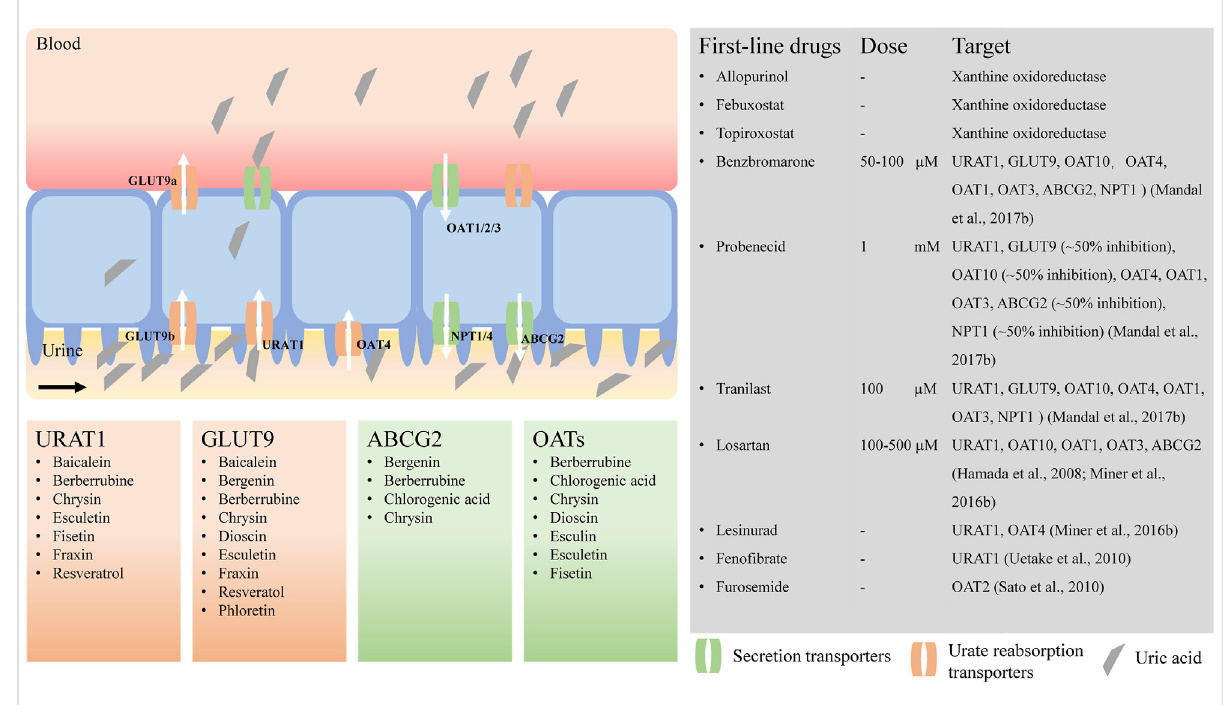
FIGURE 1 Uratetransportersandpotentialnaturalproductsforhyperuricemiatreatment.URAT1,uratetransporter1;GLUT9,glucosetransportermember 9; ABCG2, ATP-binding cassette transporter, subfamily G, member 2; OATs, organic anion transporters; NPTs, sodium-dependent phosphate cotransporter types. The activities of urate transporters were inhibited by benzbromarone (Mandal et al., 2017), probenecid (Mandal et al., 2017), tranilast (Mandal et al., 2017), losartan (Hamada et al., 2008; Miner et al., 2016b), lesinurad (Miner et al., 2016b), feno fi brate (Uetake et al., 2010), furosemide (Sato et al., 2010),